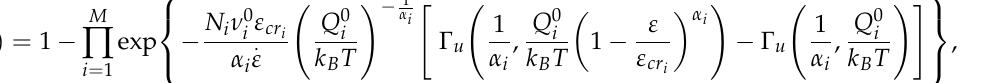
Figure 9. Free Energy Barrier for the acute and obtuse angles for different strain values.